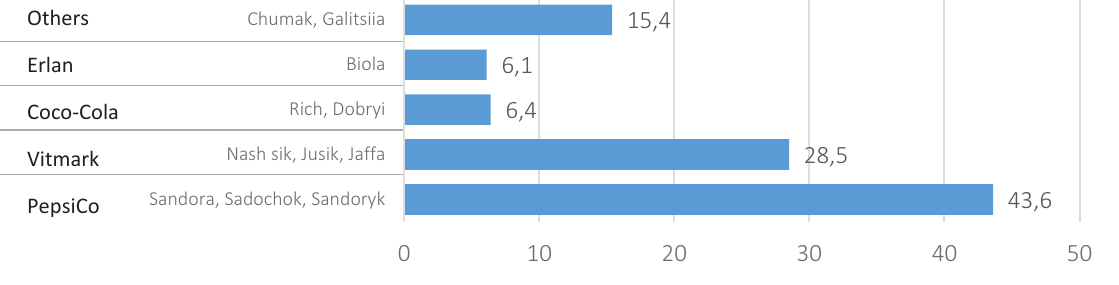
Figure 2. Distribution of market shares (%) on the juice market of Ukraine in 2017